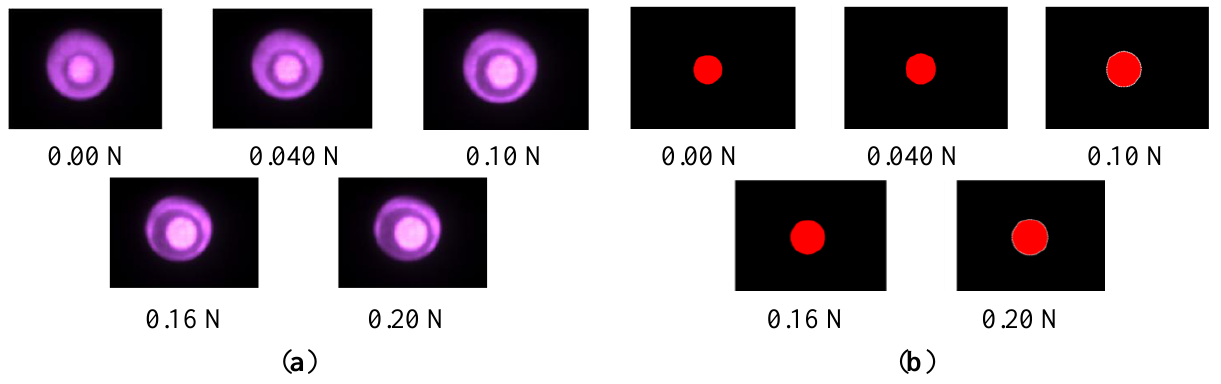
Figure 9. ( a ) Image captured by camera attached to fiberscope. ( b ) Circular pin image.